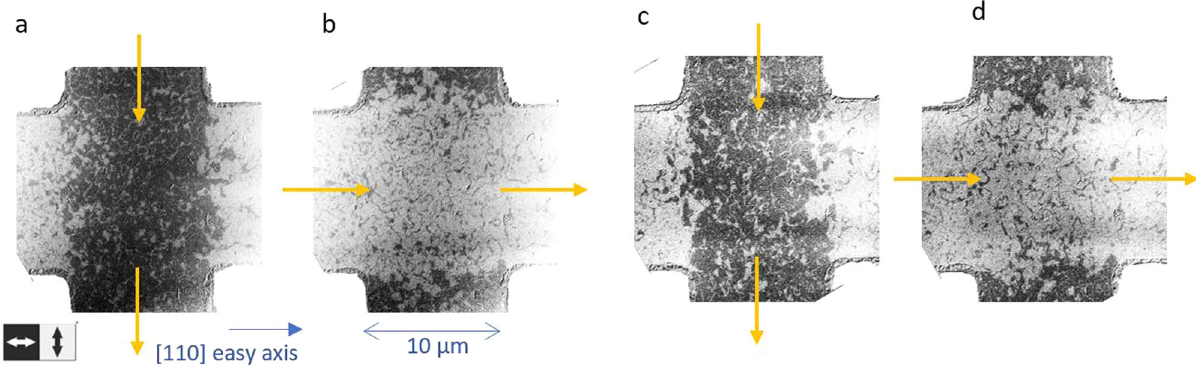
Fig.1|XMLD-PEEMimagesofreversibleNéelvectorreorientation,withcurrent parallel easy axes. The images show the orientation of the Néel vector of Mn 2 Au(001) thin fi lms after sending current pulses with different length and direction (yellow arrows) through a patterned cross structure oriented parallel to the easy 〈 110 〉 directions. The dark regions correspond to a horizontal, the bright